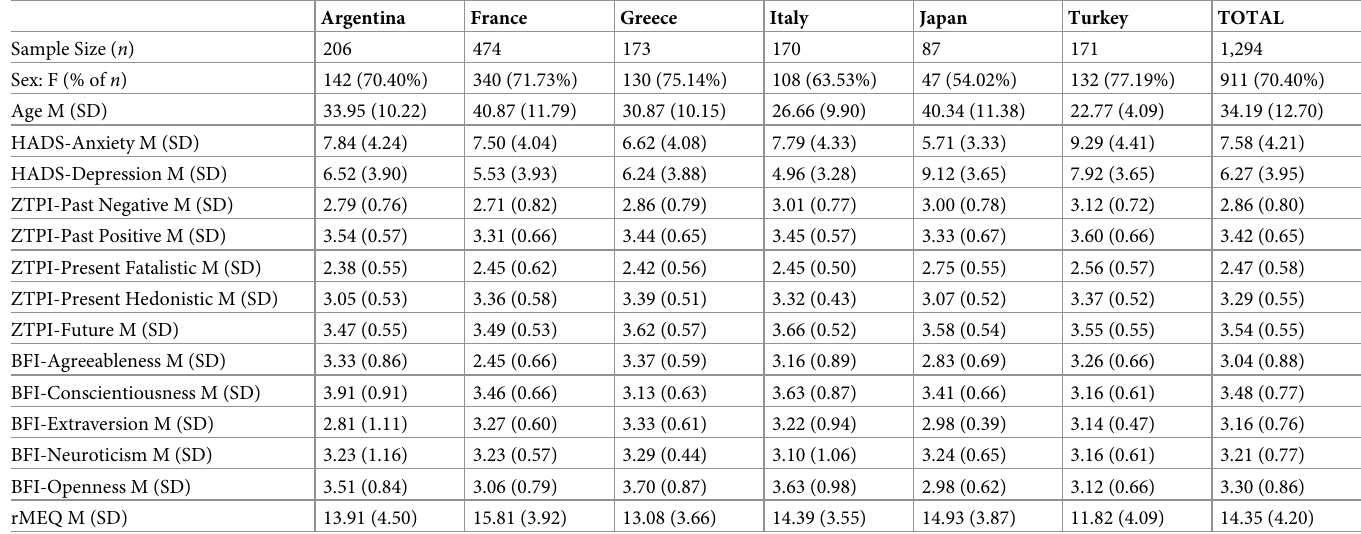
Table 3. Descriptive statistics of the study variables for the whole sample and separately for each country.